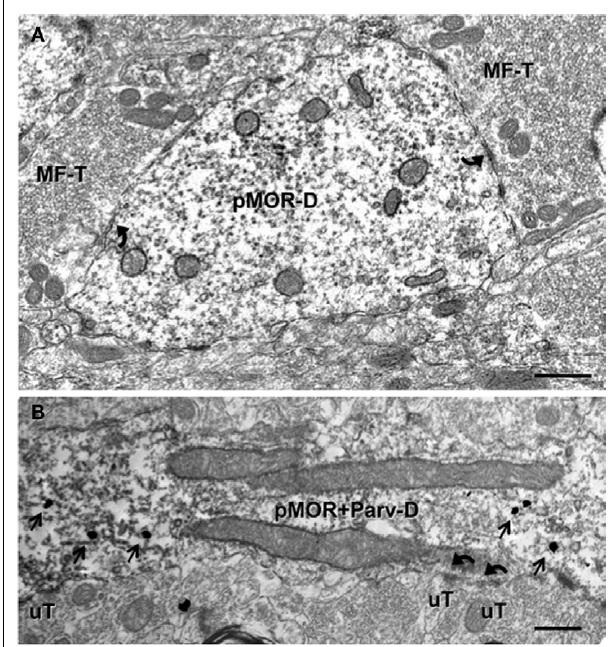
FIGURE 4 | pMOR-ir is found in dendrites, some of which colocalize PARV. (A) A large dendritic shaft containing diffuse pMOR-ir (pMOR-D) is contacted (arrows) by mossy fiber terminals (MF-T). (B) pMOR-ir identified by silver intensified gold particles (arrows) is in a PARV-labeled dendritic shaft identified by diffuse peroxidase reaction product. Unlabeled terminals (uT) form asymmetric synapses (arrows) on the dual labeled dendrite (pMOR–Parv-D). Scale bars for all images =